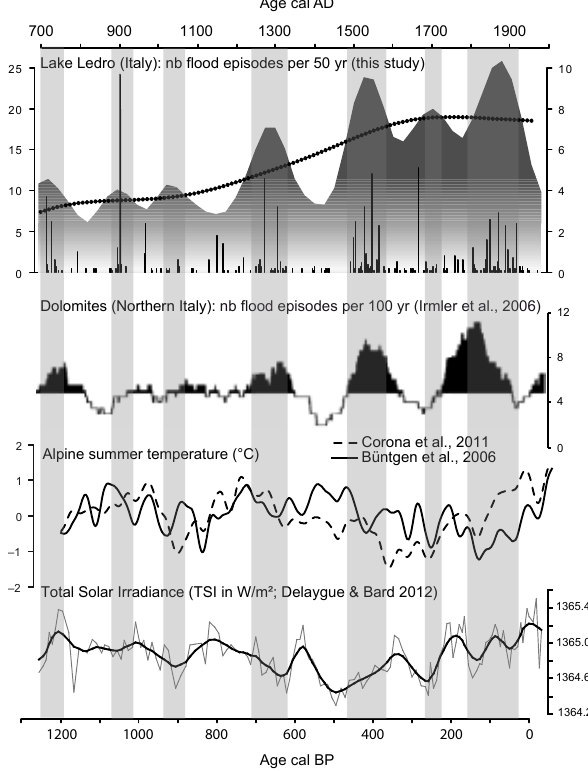
Fig. 8. Lake Ledro’s flood frequency for the last 1300yr, com- pared with debris flow records from Lago di Braies (Dolomite Alps, 150km NE from Lake Ledro (Irmler et al., 2006), with Alpine tem- peratures reconstructed from tree-ring studies (B¨untgen et al., 2006; Corona et al., 2011) and with total solar insolation reconstructed from 10 Be records (Delaygue and Bard,